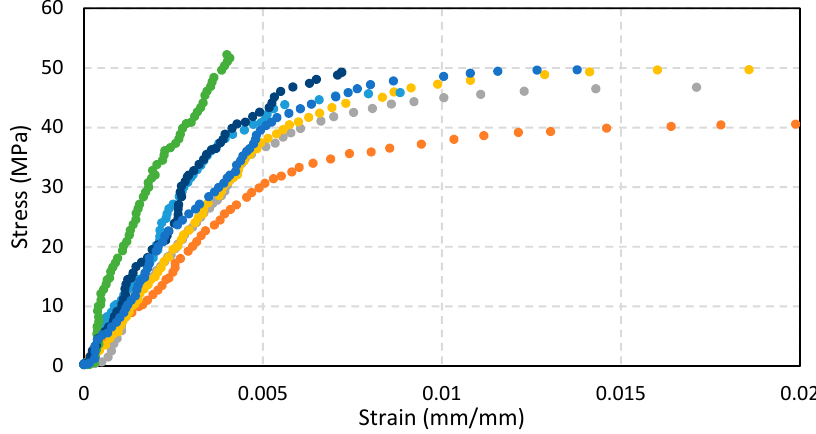
/ strain curves of the Series A Figure 7. Comparison of the stress/strain curves of the Series A tests. Figure 7. Comparison of the stress